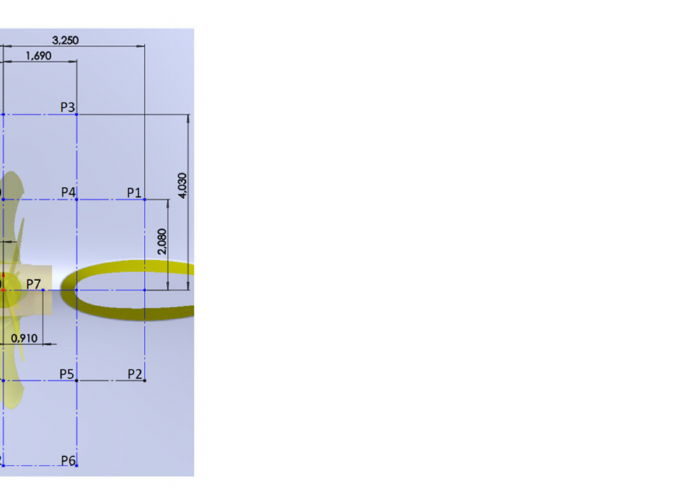
Figure 16. SCHOTTEL reference case 1. Locations of the acoustic observers on the hull with respect to the propeller and the rudder of the unit at full scale; observers are symmetrical to the centerline.